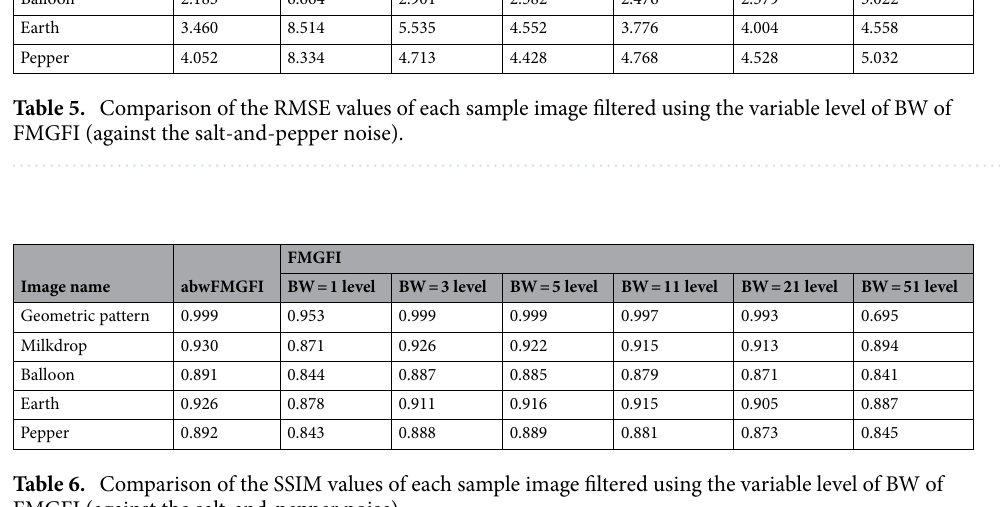
Table 6. Comparison of the SSIM values of each sample image filtered using the variable level of BW of FMGFI (against the salt-and-pepper